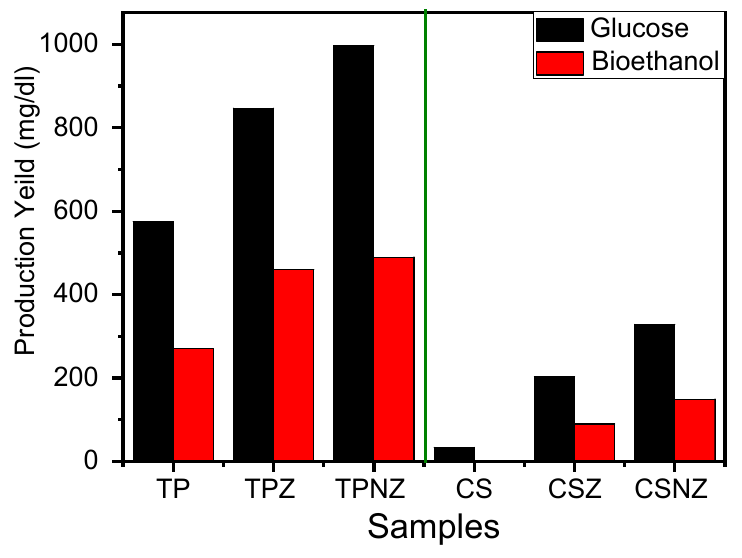
Figure 3. Produced glucose from enzymatic hydrolysis and bioethanol liberated after fermentation of the hydrolysate.